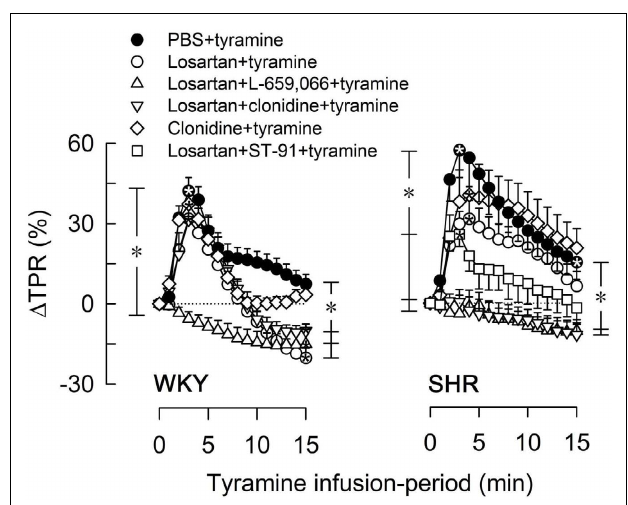
FIGURE 4 |TheTPR-response to tyramine after pre-treatment with the AT 1 R-antagonist losartan, alone or combined with L-659,066, clonidine, or ST-91 .The effect of losartan + ST-91 was tested in SHR only. Baselines prior to tyramine are shown in Table 3 . Significant responses (*within symbol) and group differences were detected at peak response ( * brackets left of curves) and at 15min ( * brackets right of curves) as indicated. *, * P ≤ 0.025 after curve